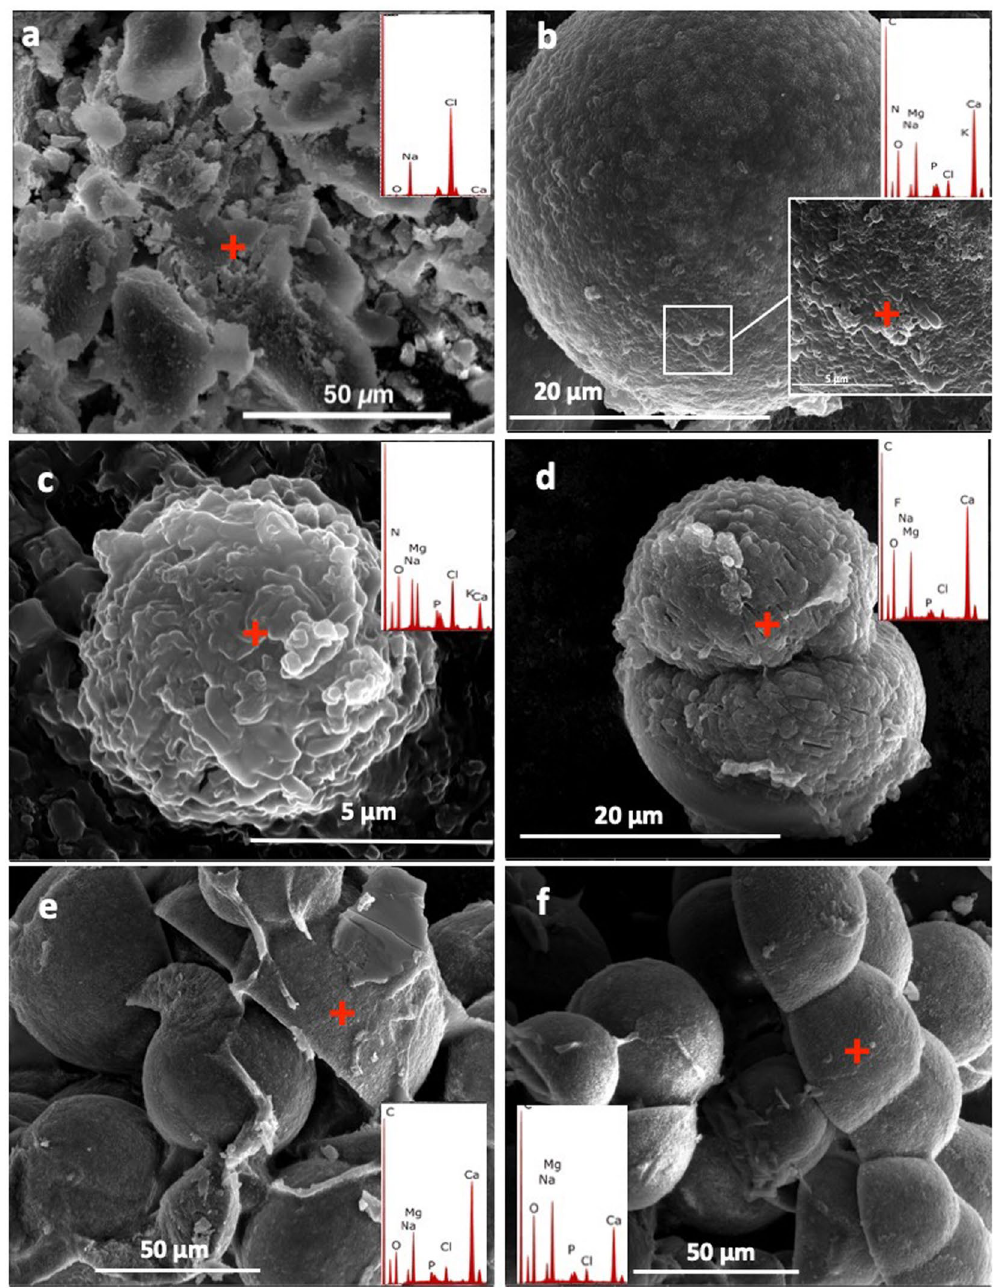
Figure 1. SEM/EDS investigations of minerals recovered from DF141, DF112 and DF2141 cultures. ( a ) Negative control DF141, elemental analysis indicates the presence of sodium chloride, ( b ) calcium carbonate crystals formed in DF112 cultures at 20 °C; close-up showing bacterial cells embedded in the calcium carbonate crystal. ( c ) Mineralized bacterial cells. ( d ) High-magnesium carbonate crystal recovered from DF112 culture at 30 °C, showing moulds of bacterial cells. Mixture of Mg-rich carbonate crystals formed in DF2141 cultures at ( e ) 30 °C and ( f ) 40 °C, showing similar morphologies but with smaller crystals and more incorporation of Mg 2 + at 40 °C. C: calcite, H: halite. Modified from corresponding PhD Dissertation 71